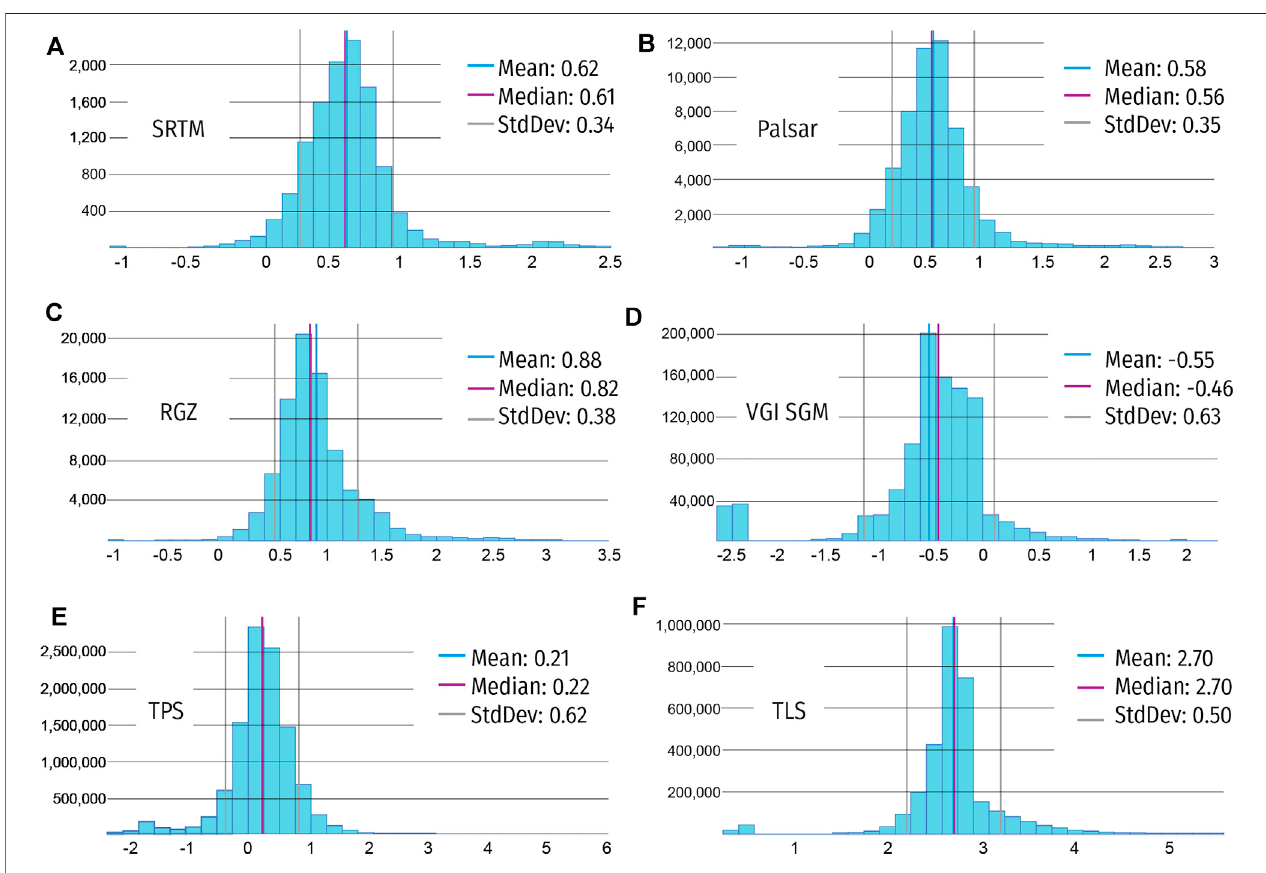
FIGURE 9 | Histogram and descriptive statistics of IC values from the analyzed DEMs: (A) SRTM; (B) PALSAR; (C) RGZ; (D) VGI SGM; (E) TPS; (F) TLS.